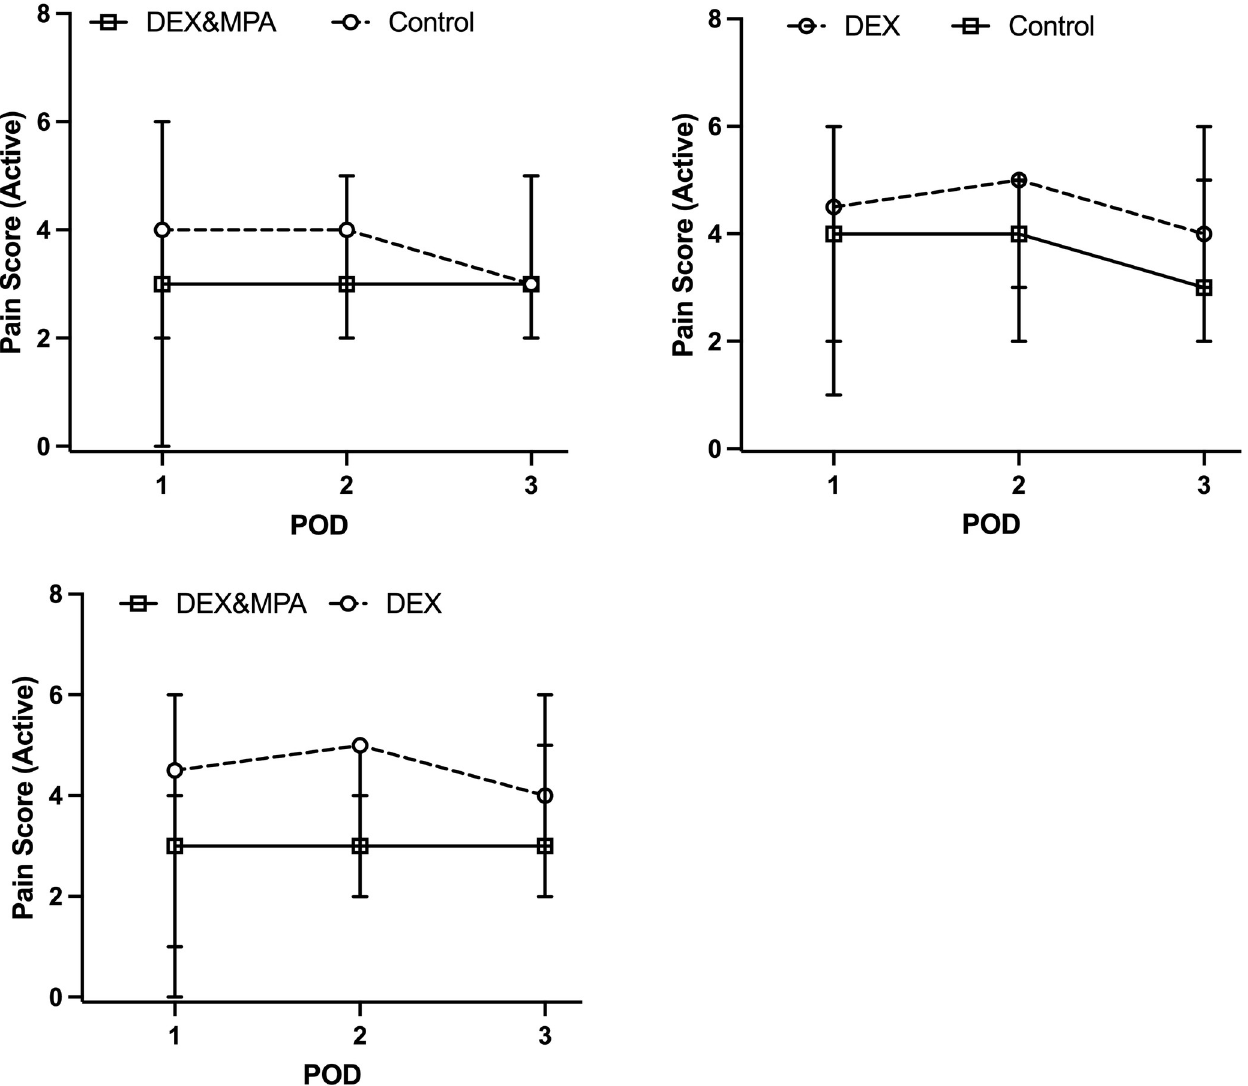
Fig 3. Progression of VAS pain score at activity (physical therapy) throughout the immediate postoperative period. Median (IQR) was plotted. VAS, visual analogue scale; POD, postoperative day; DEX, dexamethasone sodium phosphate; MPA, methylprednisolone acetate.